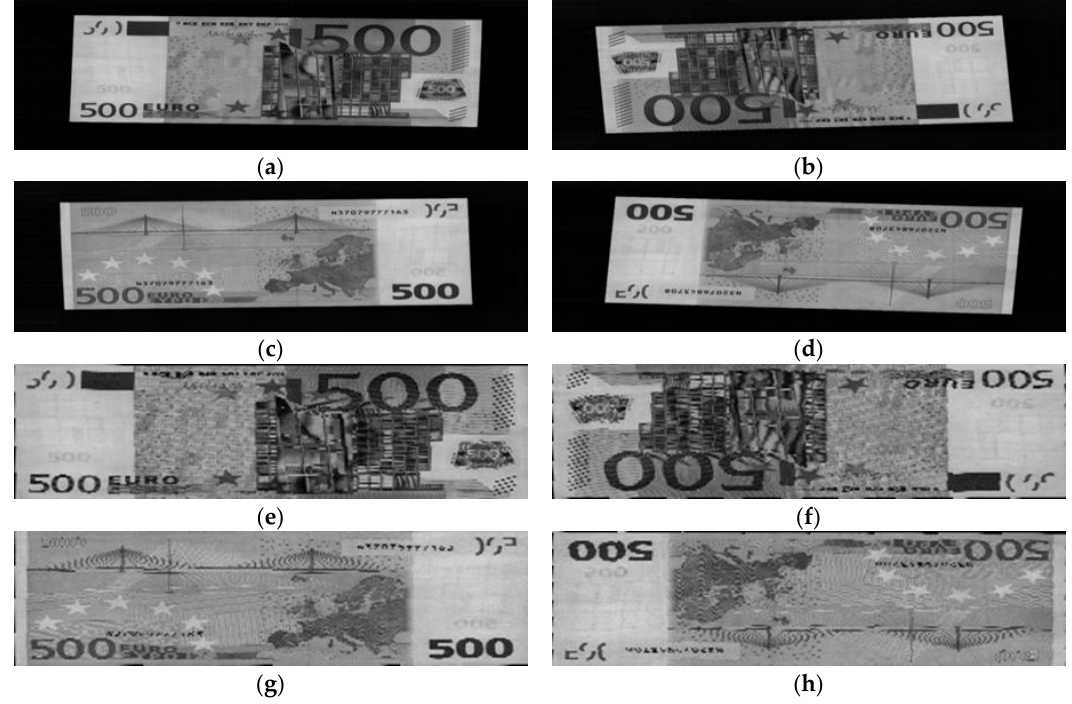
Figure 3. Examples of EUR banknote images and their corresponding banknote region segmented images in four input directions: ( a ) A direction; ( b ) B direction; ( c ) C direction; ( d ) D direction; ( e – h )